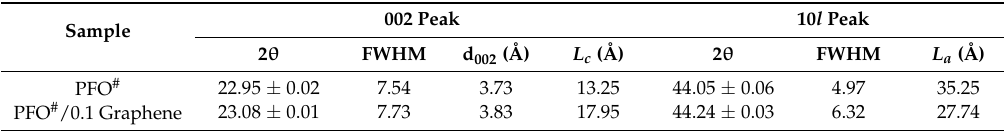
Figure 7. XRD patterns of PFO # -based carbon fibers; PFO # , PFO # /0.1 graphene . Table 3. Crystallite size results of PFO # -based carbon fibers: PFO # , PFO # /0.1 graphene.